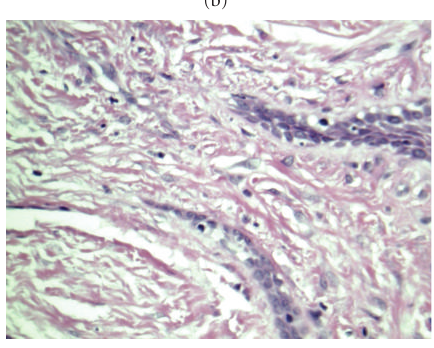
Figure 4: Histology slides of buccal lesion—focal fibrous hyperpla- sia (Fibroma).